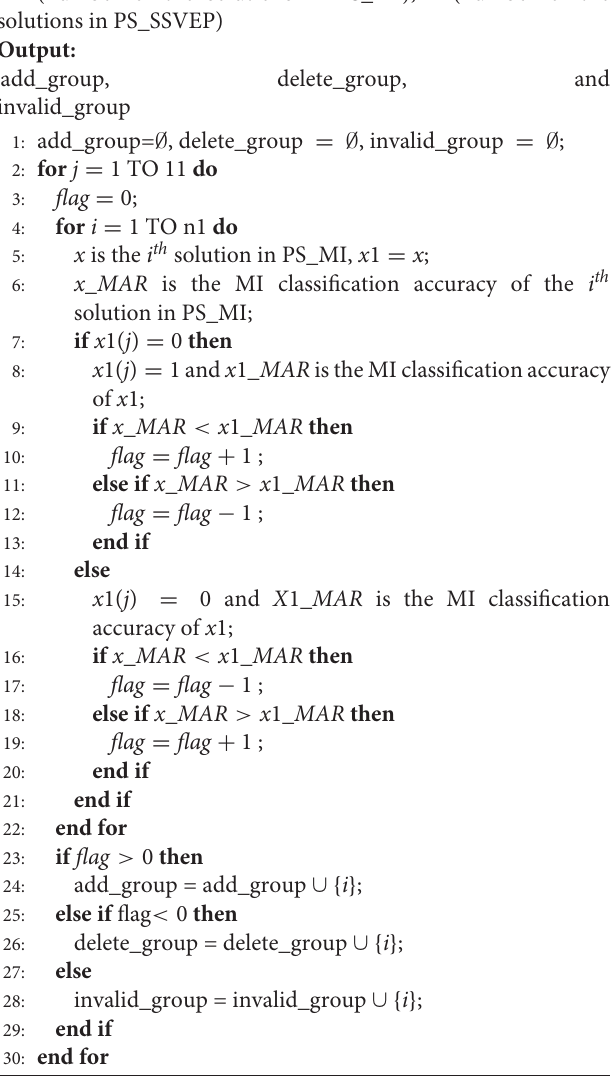
Algorithm 2 Detailed procedure of division variable analysis operator.